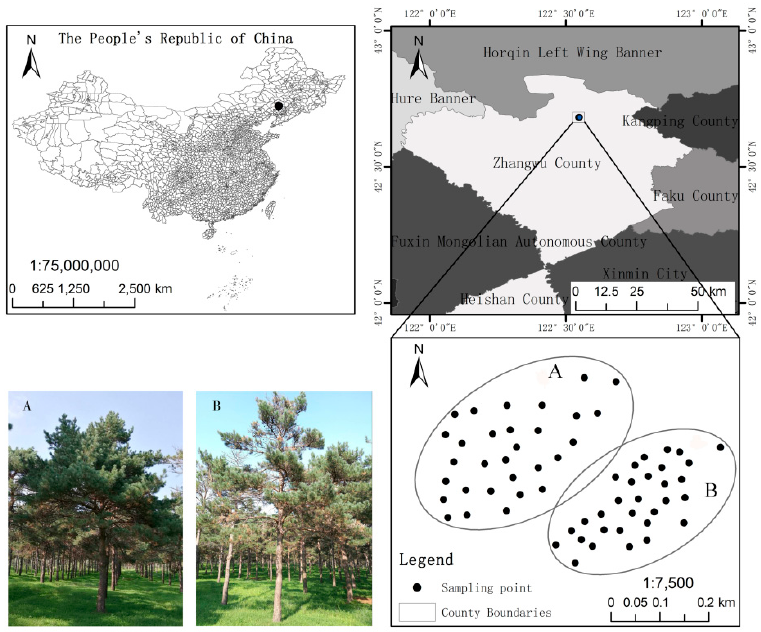
Figure 1. Location of the R&D base of the Sand Fixation and Afforestation Institute in Liaoning Province, China.